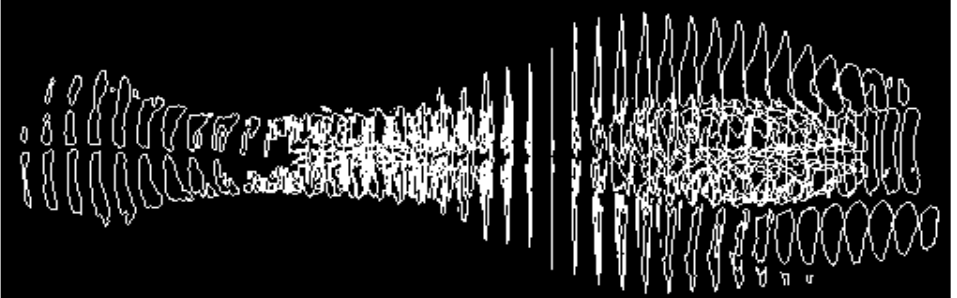
Figure 5. Illustration of a set of frontal sections of the air channel of the nasal cavity in a sagittal projection obtained as a result of segmentation of tomographic data.